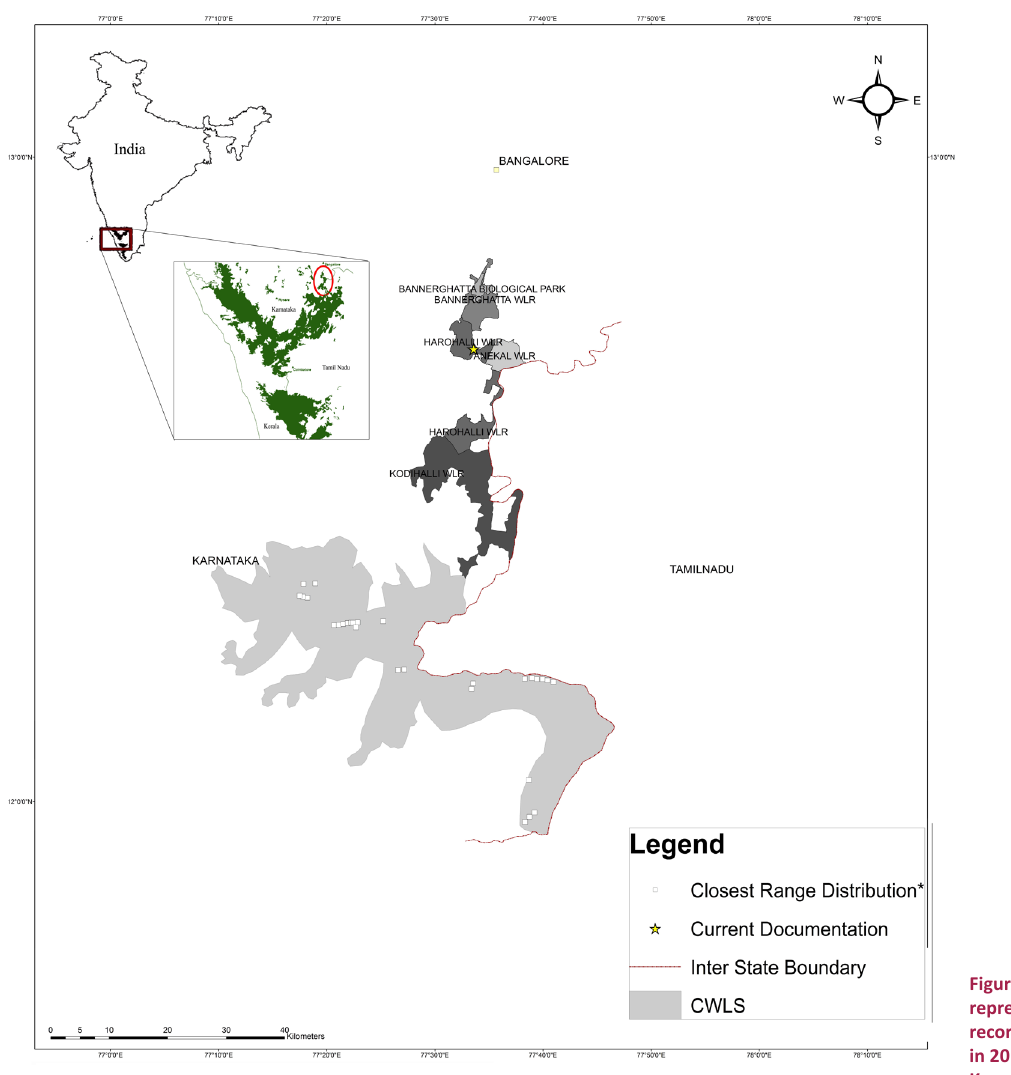
Figure 1. Spatial representation of the records of Honey Badger in 2014 and 2015 in Karnataka *approximate closest range distribution in CWLS obtained from Gubbi et al during January and March